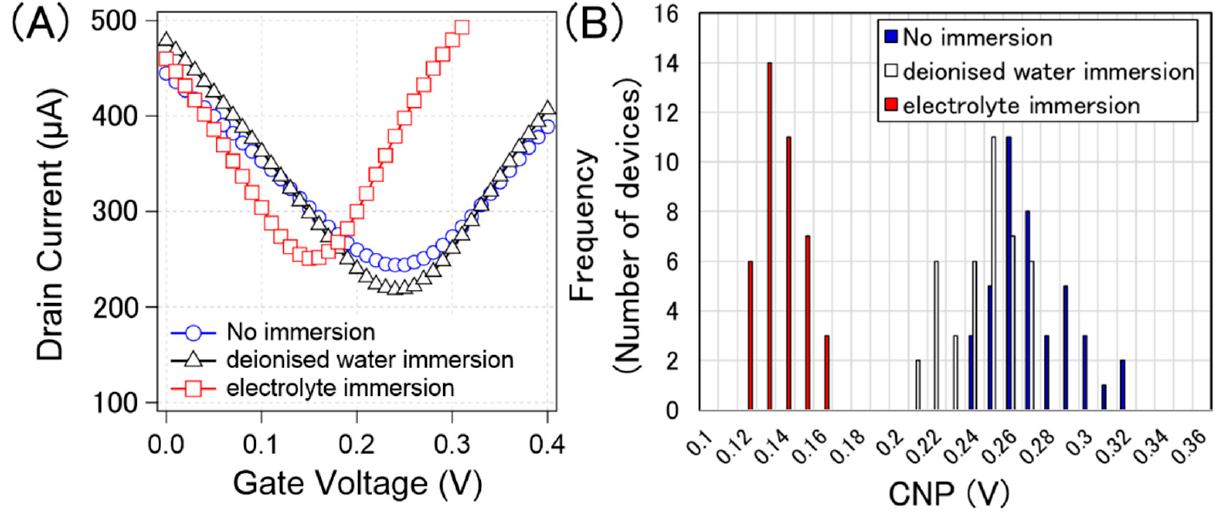
Figure 8. ( A ) Measured typical transfer curve of specific GFETs with no immersion (blue circle), immersion in deionized water (black triangle), and immersion in 0.1× D-PBS(-) (red square). ( B ) histogram of the CNPs from 40 GFETs with no immersion (blue), immersion in deionised water (white), and immersion in 0.1× D-PBS(-) (red).